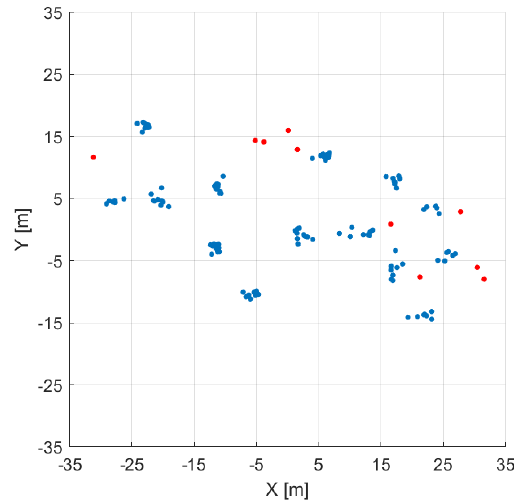
Figure 6. All collected cylinders ( x - and y -position) of one section of the V3D dataset. Outlier detected with DBSCAN are marked with red colour